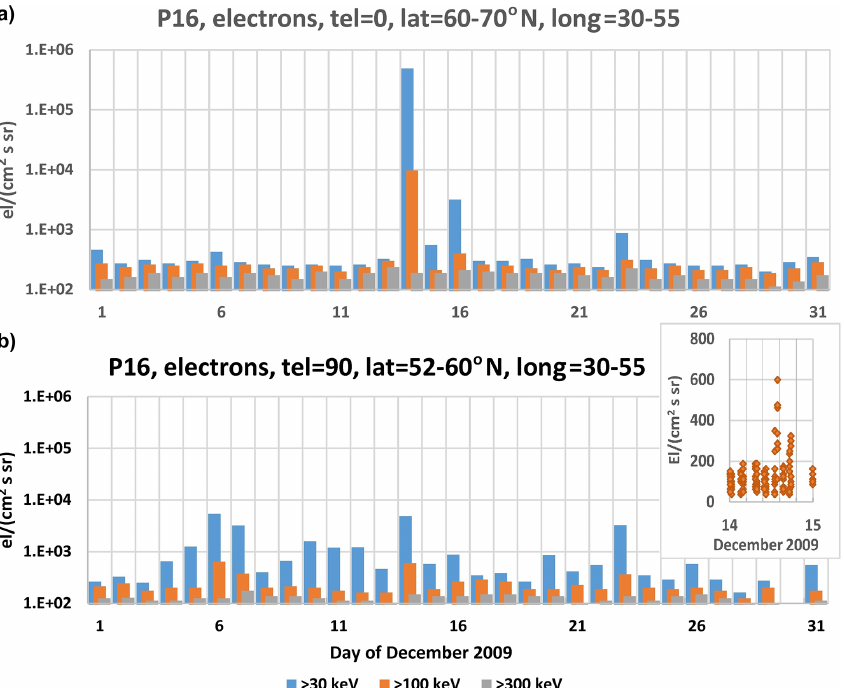
Figure 2. Daily data of POES 16 in December 2009. (a) Data on electrons recorded by the vertical telescope at the polar latitudes. (b) The same as panel (a) but for the horizontal telescope at the midlatitudes (see Sect. 2.2). The inset in panel (b) is the same as (b) but for 14 December, including the data of POES 15–18 and